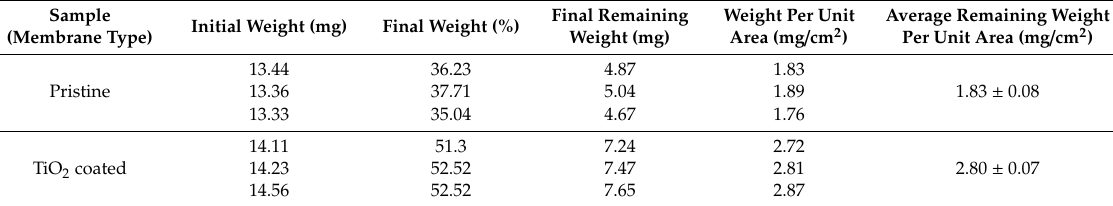
Figure 2. TGA mesurement of pristine and TiO 2 -coated membranes: temperature range (30–900 °C), total membrane area (2.66 cm 2 ), average initial weight of pristine membrane ( ≈ 13.4 mg) and TiO 2 -coated membrane ( ≈ 14.3 mg). Table 1. Quantification of TiO 2 amount coated on the membrane.